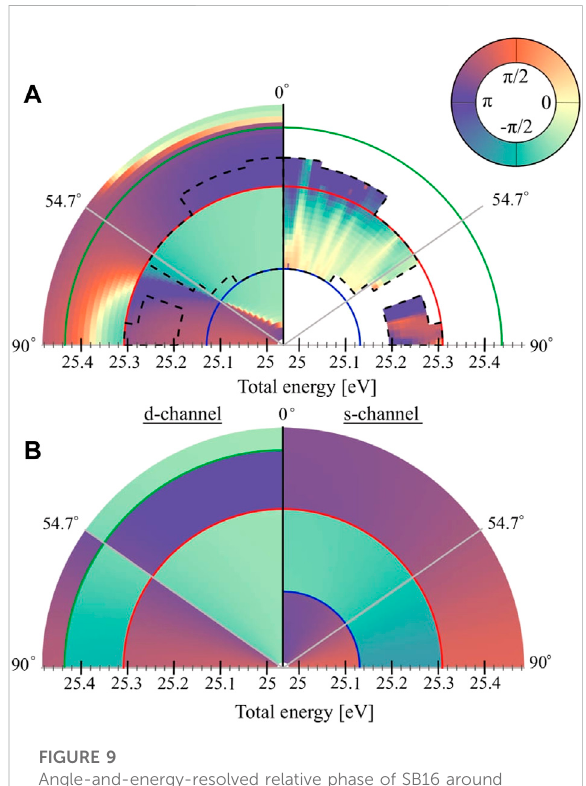
Angle-and-energy-resolved relative phase of SB16 around the4presonance. (A) Comparisonbetweenexperiment(right)and theory (left). Only the experimental results with signi fi cant signal- over-noise ratio are presented. This region is indicated by the black dashed line. The radial coordinate is the total energy, while the polar angle is the electron emission angle relative to the polarization axis. The cyclic color bar is shown in the top right of the fi gure. In (B) , we present the contribution of the s (right) and d (left) waves in the absorption path to the total phase